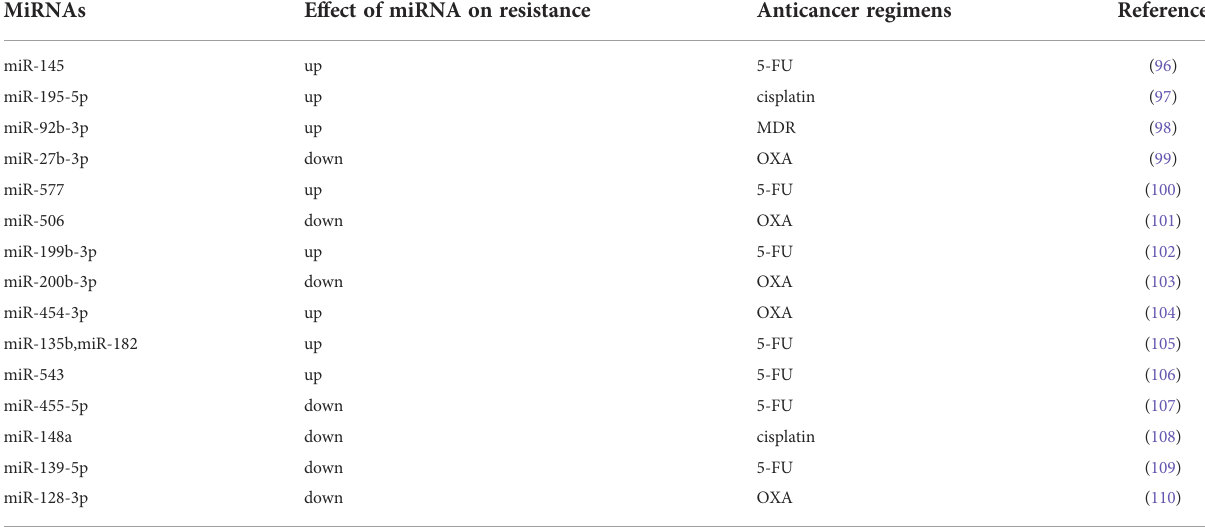
TABLE 2 Effects of miRNAs on anticancer regimens in CRC in vitro and in vivo studies.